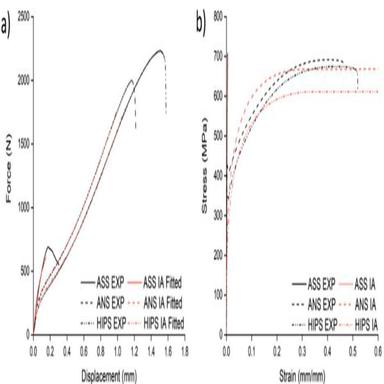
Results of the inverse analysis on 316L steel: (a) force-displacement and (b) stress–strain curves.